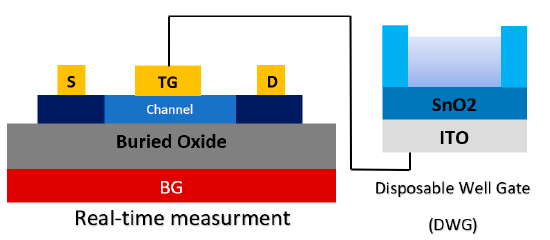
Figure 18. Illustration of the avian influenza virus (AIV) sensor configuration, which is a combination of double-gate and extended gate configuration.